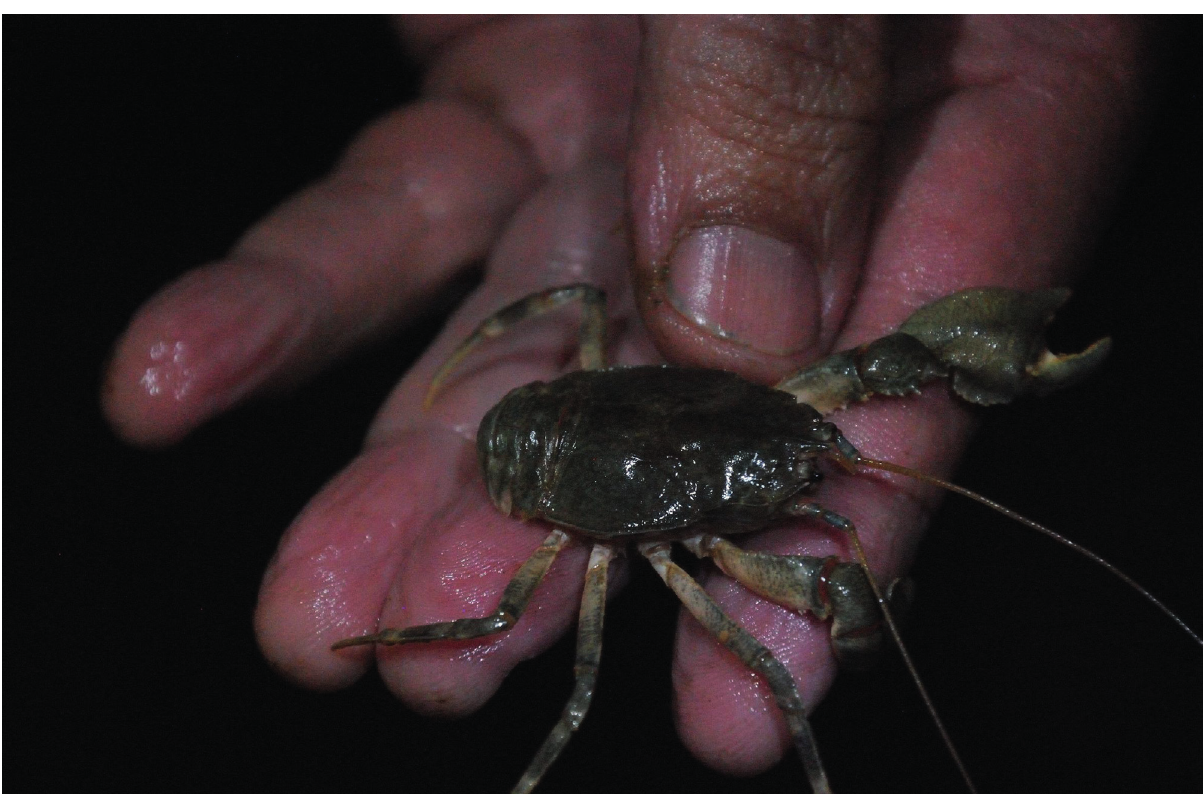
Figure 4. Live male specimen of Aegla charon n. sp. Photo by Alexandre L.